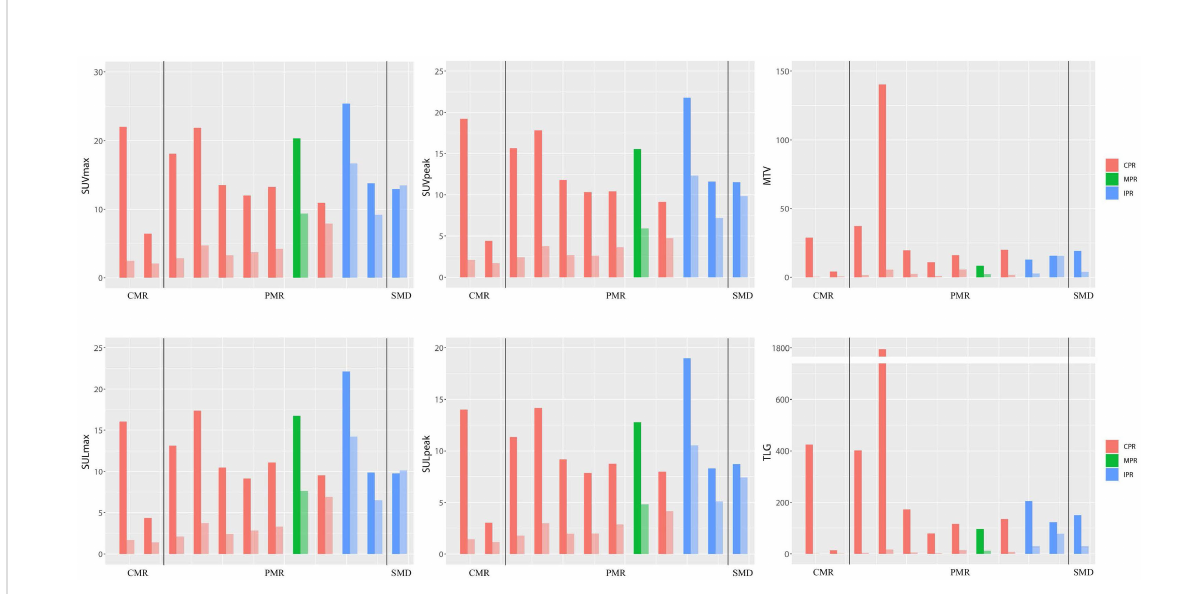
FIGURE 3 Bar plot for six SUV statistics features of paired PET (baseline and preoperative). The dark colors represent baseline PET features, and the light colors represent preoperative PET features. The patient number from left to right is 16, 5, 21, 23, 4, 12, 20, 19, 1, 14, 18, and 22, respectively. CMR, complete metabolic response; PMR, partial metabolic response; SMD, stable metabolic disease; CPR, complete pathological response; MPR, major pathological response; IPR, incomplete pathological